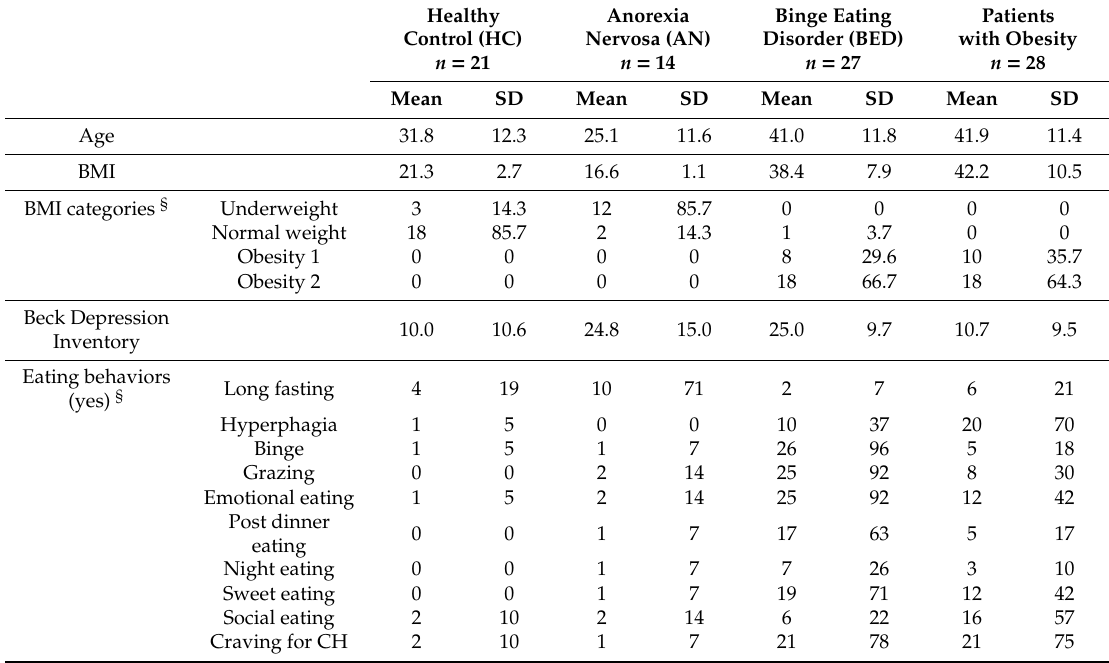
Table 1. Demographic and clinical characteristics of the study